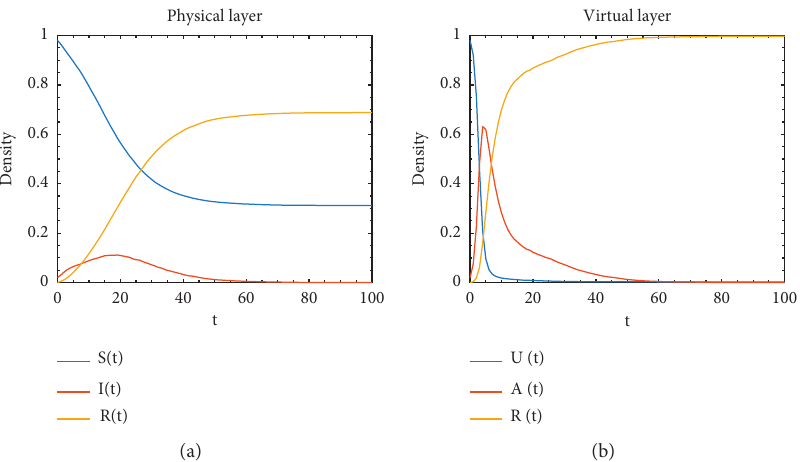
Figure 3: Temporal progress of epidemic spreading and information dissemination. (a) The evolution of epidemic spreading over time. (b) The evolution of information dissemination over